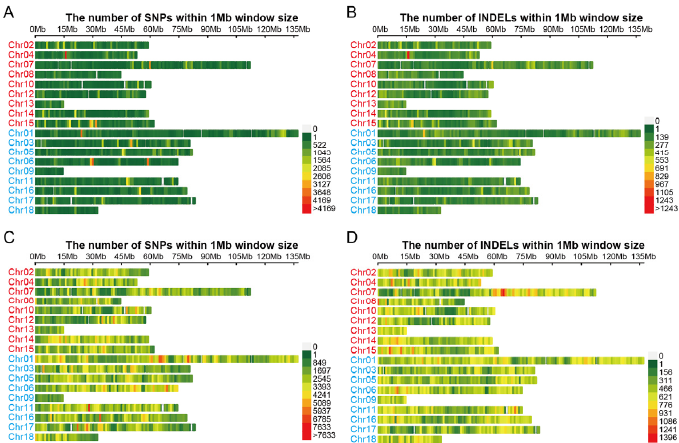
Figure 2. Total chromosome-targeted SNPs and INDELs. ( A – B ) The total SNPs ( A ) and INDELs ( B ) when both Longli-4 and CA3-1 were included for variation calling. Numbers in sky blue ellipses represent that SNPs and INDELs had no read-support information in Longli-4 and were assigned as ‘N’. Numbers in light coral ellipses represent variances with missing information in CA3-1. Numbers with color overlap show that these SNPs and INDELs were identified in both Longli-4 and CA3-1.